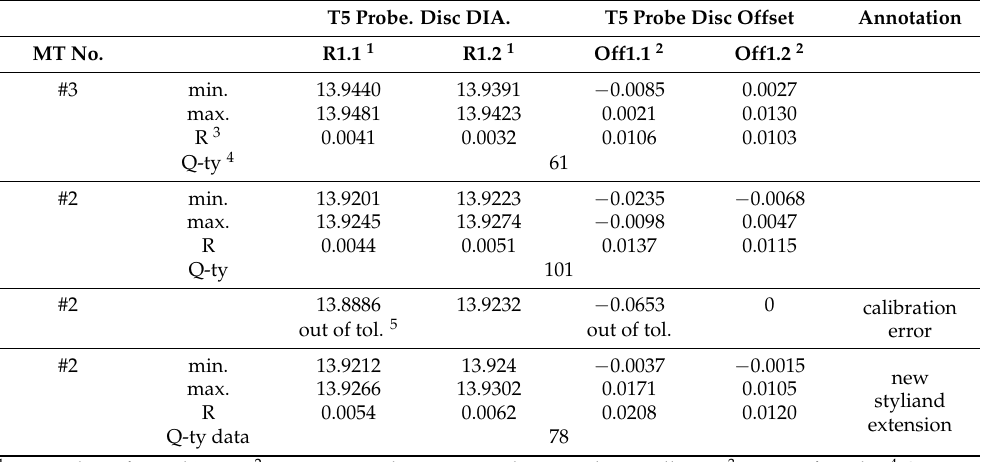
Table 8. Measurement dispersion for P6 area, B 90° head positions for the probes T1, T2, T9, T5, and B 0° head position for T4. Results in [mm]. Table 10. Comparison of probing data of T5#3 and T5#2 probe. Key data shown. Results in [mm]. T5 Probe. Disc